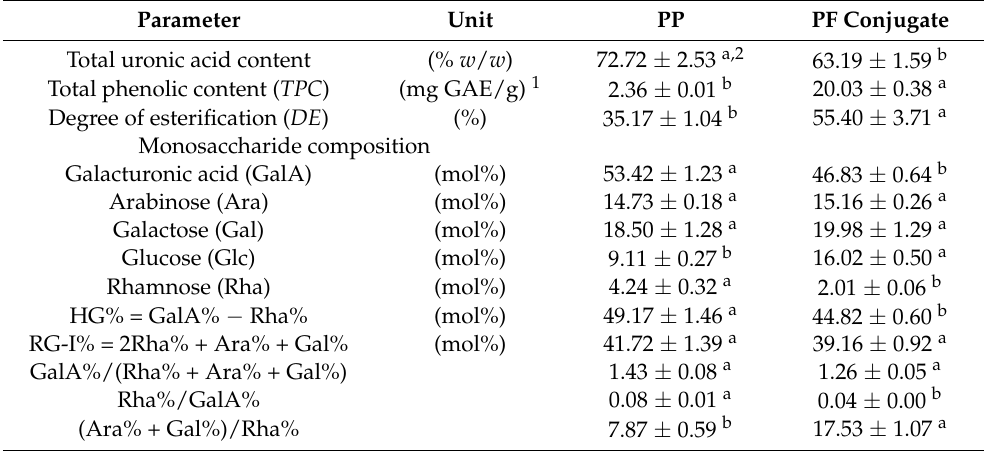
Table 1. Approximate compositions, monosaccharide compositions, and ratios of PP and PF conjugates. Parameter Unit PP PF Conjugate Total uronic acid content (% w / w ) 72.72 ± 2.53 a,2 63.19 ± 1.59 b Total phenolic content ( TPC ) (mg GAE/g) 1 2.36 ± 0.01 b 20.03 ± 0.38 a Degree of esterification ( DE ) (%) 35.17 ± 1.04 b 55.40 ± 3.71 a Monosaccharide composition Galacturonic acid (GalA) (mol%) 53.42 ± 1.23 a 46.83 ± 0.64 b Arabinose (Ara) (mol%) 14.73 ± 0.18 a 15.16 ± 0.26 a Galactose (Gal) (mol%) 18.50 ± 1.28 a 19.98 ± 1.29 a Glucose (Glc) (mol%) 9.11 ± 0.27 b 16.02 ± 0.50 a Rhamnose (Rha) (mol%) 4.24 ± 0.32 a 2.01 ± 0.06 b HG% = GalA% − Rha% (mol%) 49.17 ± 1.46 a 44.82 ± 0.60 b RG-I% = 2Rha% + Ara% + Gal% (mol%) 41.72 ± 1.39 a 39.16 ± 0.92 a GalA%/(Rha% + Ara% + Gal%) 1.43 ± 0.08 a 1.26 ± 0.05 a Rha%/GalA% 0.08 ± 0.01 a 0.04 ± 0.00 b (Ara% + Gal%)/Rha% 7.87 ± 0.59 b 17.53 ± 1.07